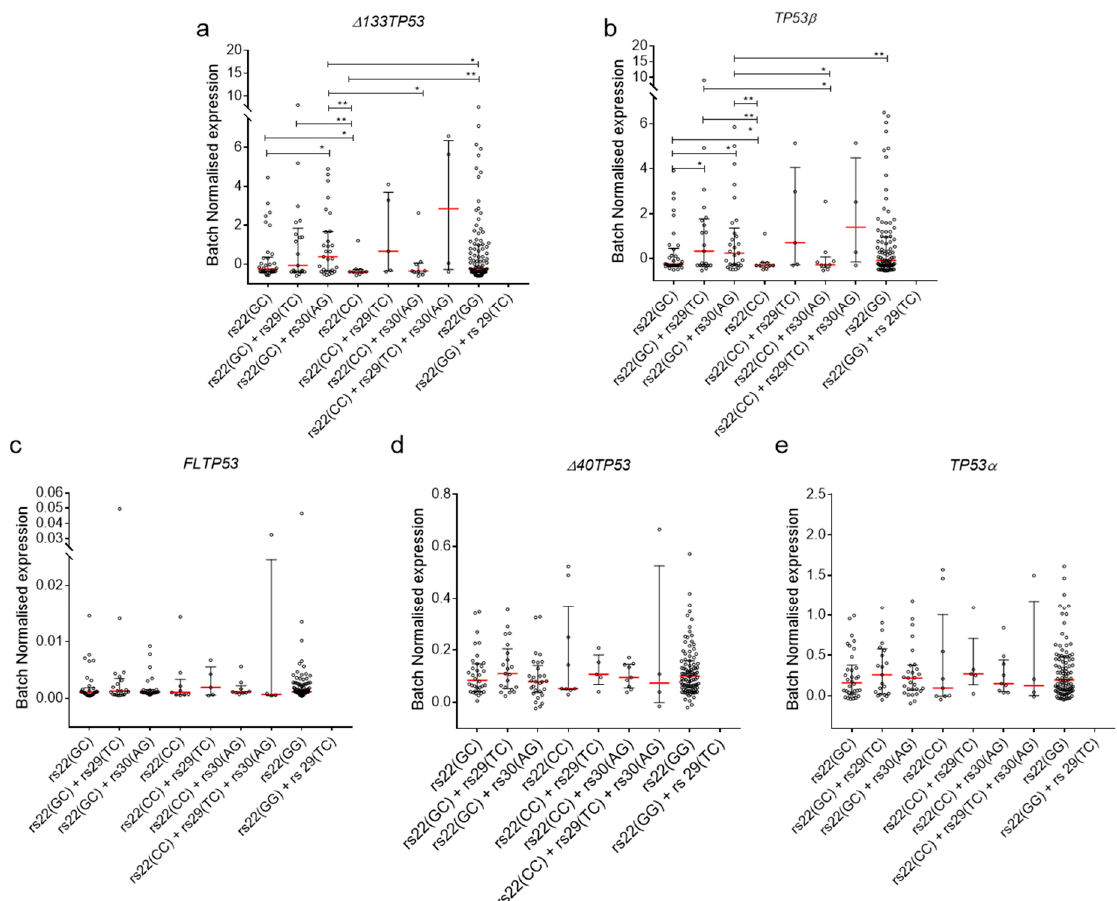
Figure 4. Intronic SNPs (rs29 and rs30) are associated with elevated mRNA levels of ∆ 133TP53 and TP53 β in GBM and PCa. ( a ) ∆ 133TP53 , ( b ) TP53 β , ( c ) FLTP53 , ( d ) ∆ 40TP53 and ( e ) TP53 α mRNA expression from GBM and PCa. ( a – e ) Dot plot of batch normalised mRNA expression of TP53 isoforms. Red line—median with whiskers—interquartile range. Significance was determined using Welch’s t-test. *— p value. * < 0.05, ** < 0.01.